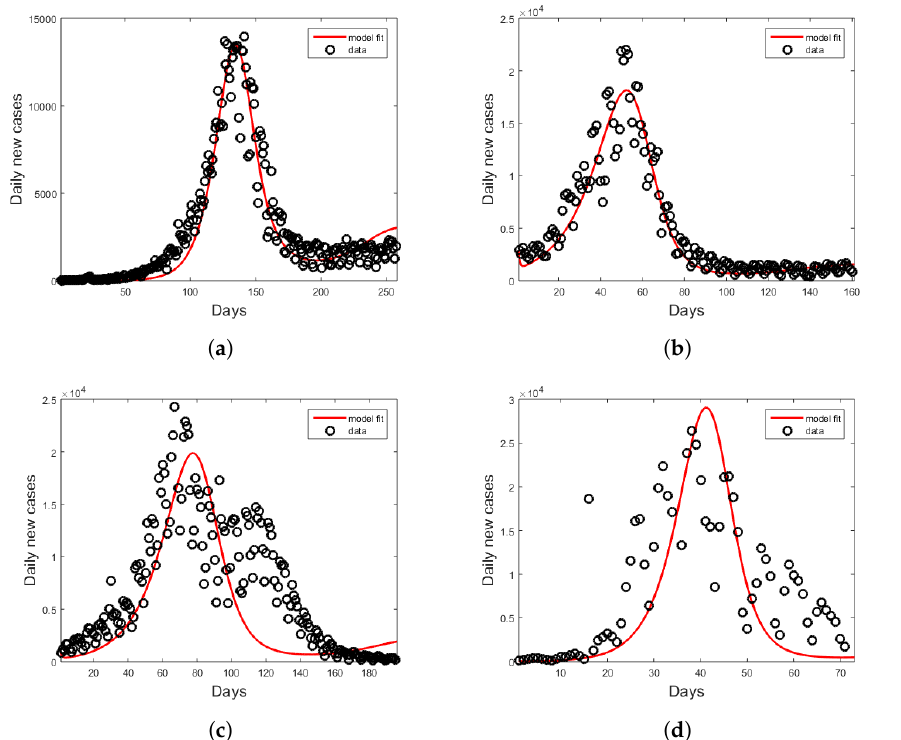
Figure 2. Model fit to data for COVID-19 waves in South Africa. ( a ) Wave 1 model fit. ( b ) Wave 2 model fit. ( c ) Wave 3 model fit. ( d ) Wave 4 model